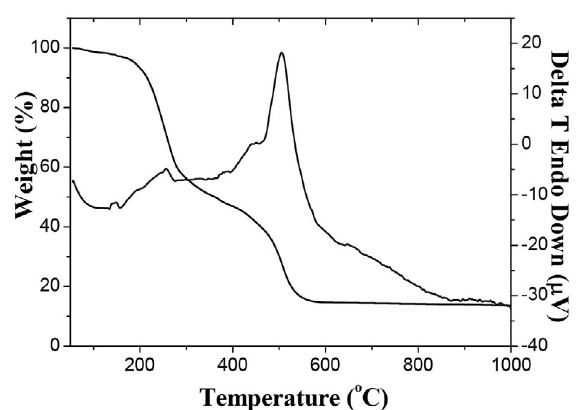
Figure 3. Molecular packing of 1 , viewed along the a axis. Hydro- gen bonds are drawn as dashed lines. Hydrogen atoms not related to hydrogen bonds are omitted for clarity.